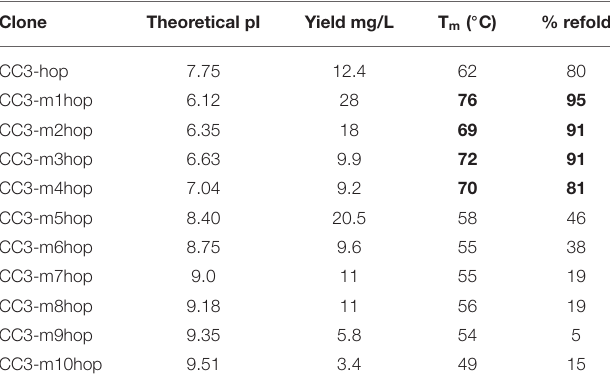
TABLE 1 | Theoretical pI, protein yield, melting temperature (T m ), and percent refolding of the CC3-hop